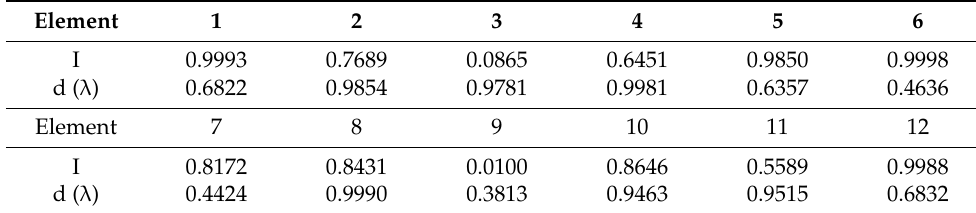
Table 7. Amplitude (I) and element spacing (d) obtained by using AMPA for 12-element CAA PSLL